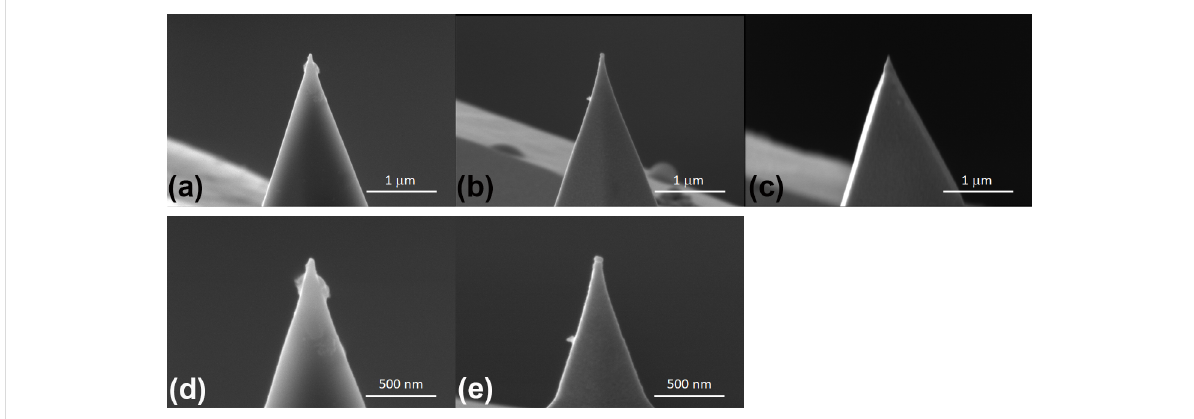
Figure 7: SEM images of the AFM tips used to collect the results presented in Figure 2: (a, d) SiO x tip, (b, e) Au tip, and (c) PtSi tip.